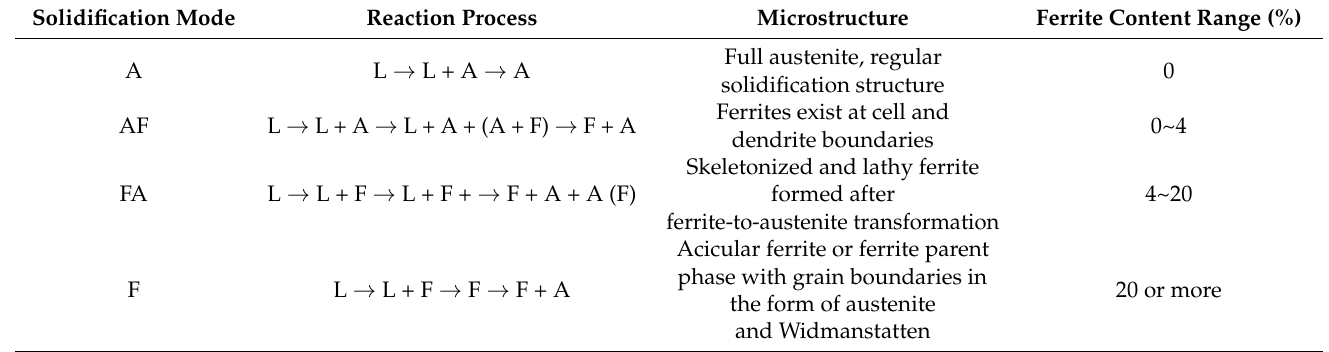
Table 4. Solidification mode, reaction process, and microstructure of austenitic stainless steel welding. Solidification Mode Reaction Process Microstructure Ferrite Content Range (%) Full austenite, regular solidification structure dendrite boundaries Skeletonized and lathy